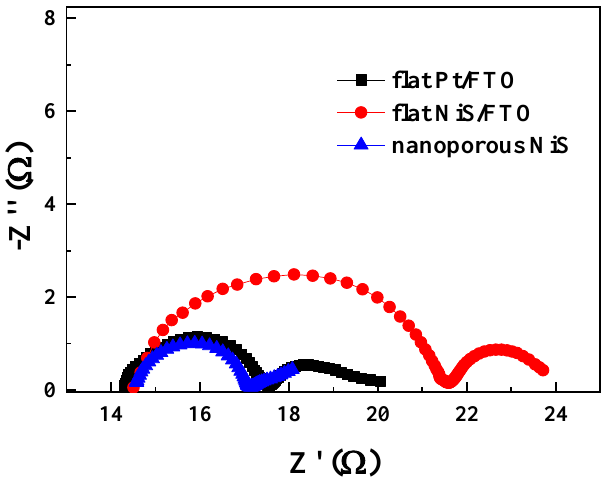
Figure 4. Nyquist plots of nanoporous NiS, flat NiS/FTO, and flat Pt/FTO.